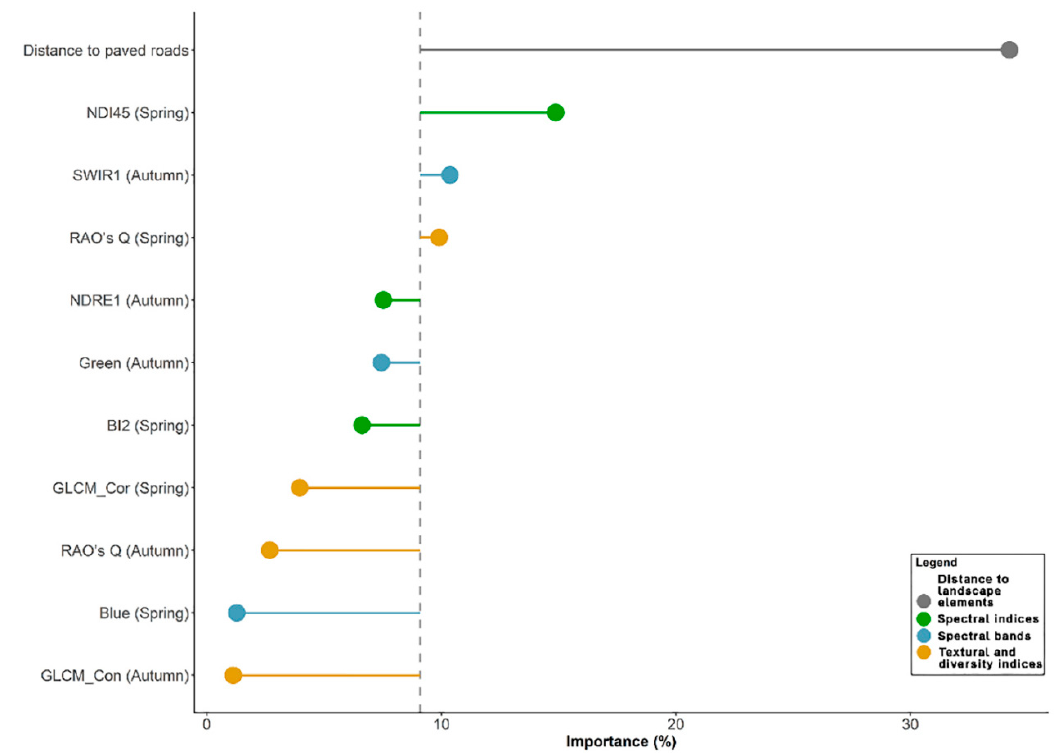
Figure 2. The relative contribution of retained variables (%) in the final habitat suitability model, layered with respective groups (grey dot: Distance to landscape element; green dots: Spectral indices; cyan dots: Spectral bands; orange dots: Textural and diversity indices) and overlapped with a dashed line representing mean importance value.